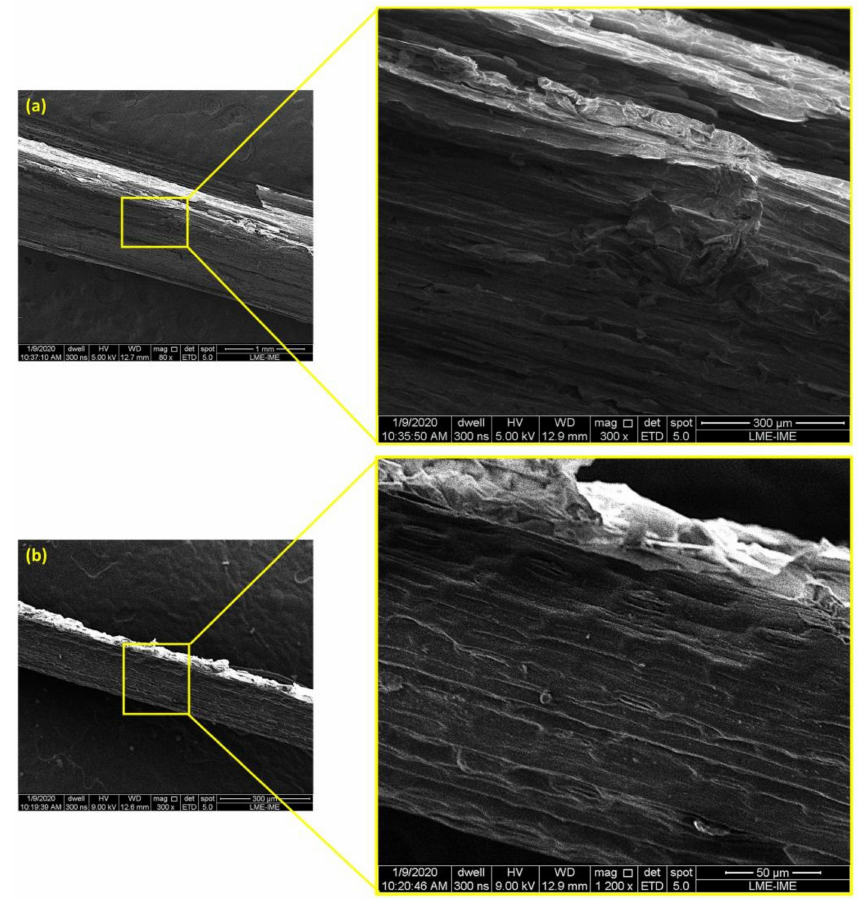
Figure 4. SEM images of the surface of the sedge fibers: ( a ) Surface of the thicker fibers exhibiting higher density of defects—magnifications of 80 and 300 × ; ( b ) Surface of the thinner fibers showing fewer defects along the fiber—magnifications of 300 and 1200 ×